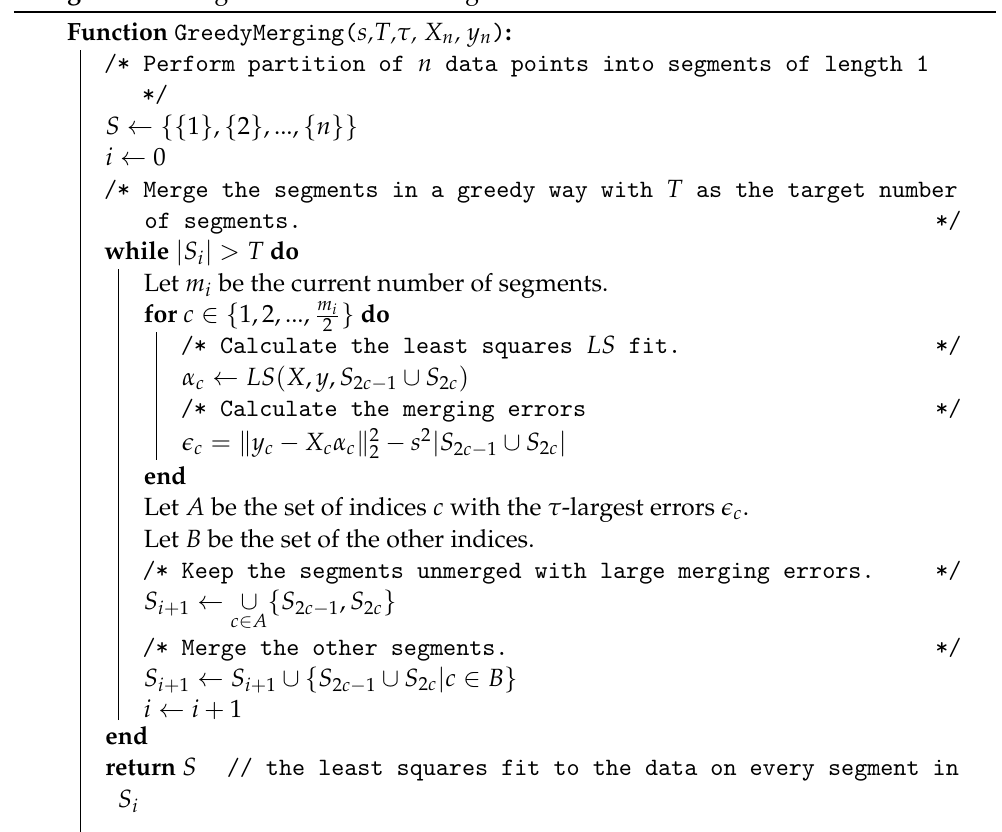
Algorithm 1: Segmented Nonlinear